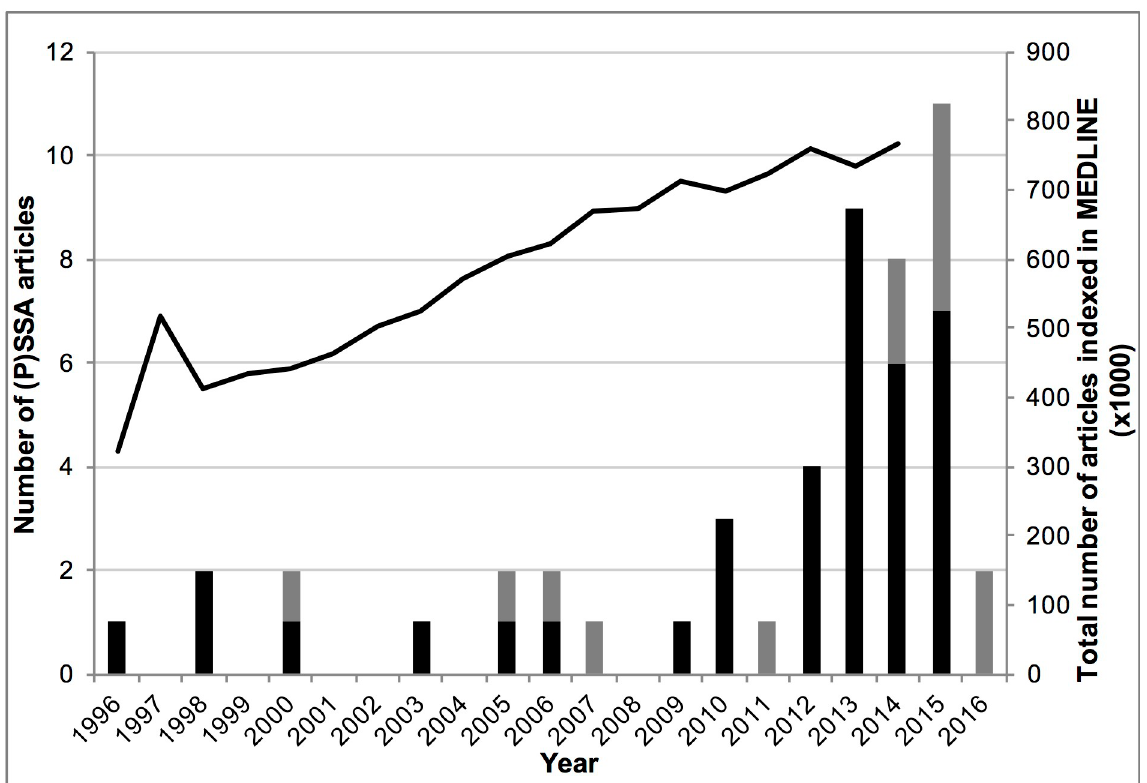
Fig 3. Number of (P)SSA articles published per year. Number of PSSA articles (black bar) and number of SSA articles (grey bar) published per year and the total number of articles indexed in MEDLINE (black line) per year after the introduction of the method in 1996 (first bar in the graph).